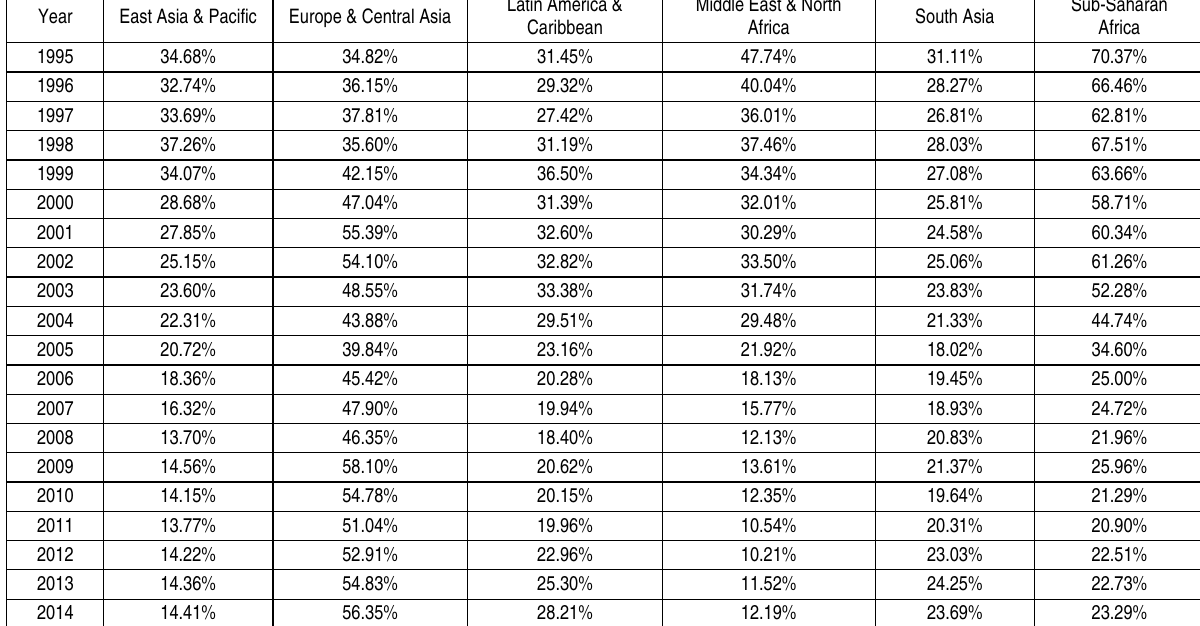
Table 6. Trends in total gross external debt to GDP region-wise